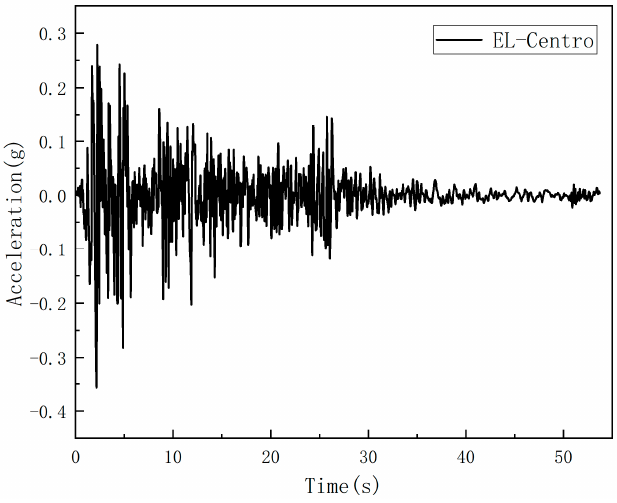
Figure 5. Acceleration–time history curve of the El Centro earthquake wave.